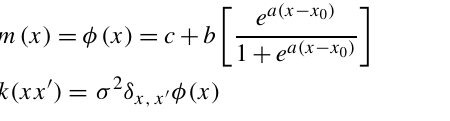
Table 3. For both the log-normal and gamma distributions